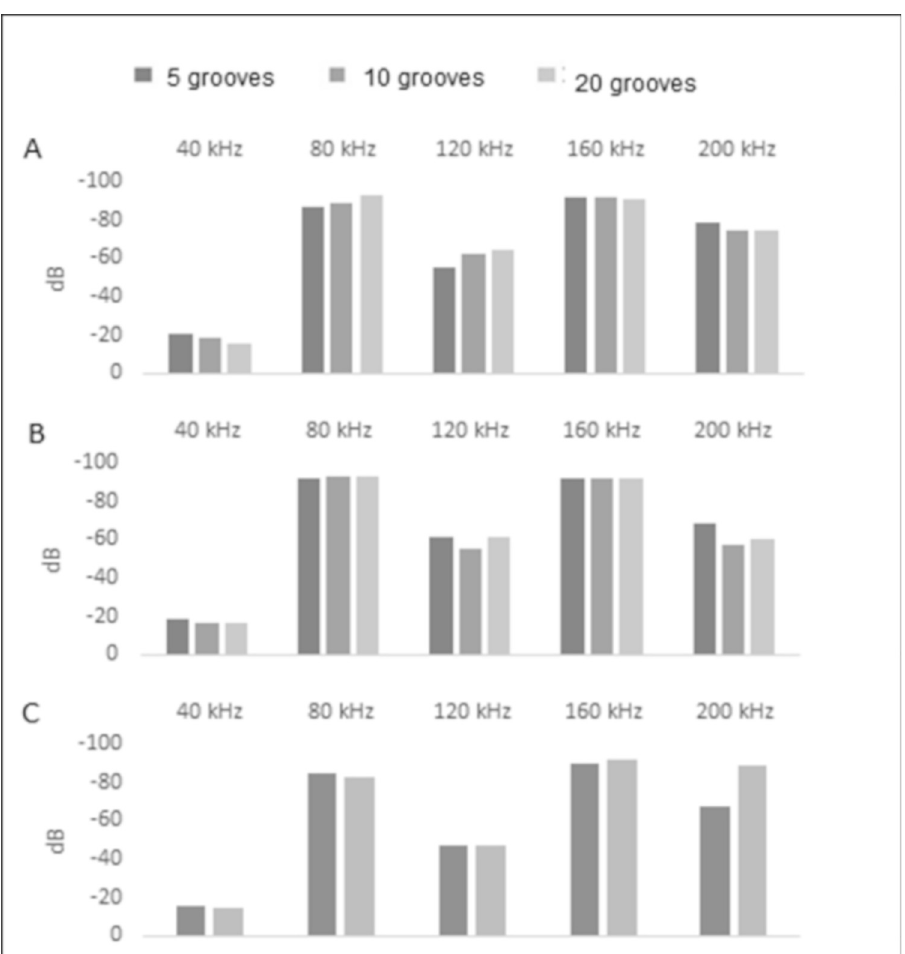
Fig 8. Groove number amplitude comparisons from the 40 kHz continuous tests. Amplitude in decibels (dB) of 40 kHz continuous tone sound waves with harmonics generated at 40 cm distance and reflected by pinna models with 5,10, and 20 grooves. Groove separation was 1 mm (A), 1.7 mm (B), and 3 mm (C). The strongest signal responses denoted in dB are closer to zero.